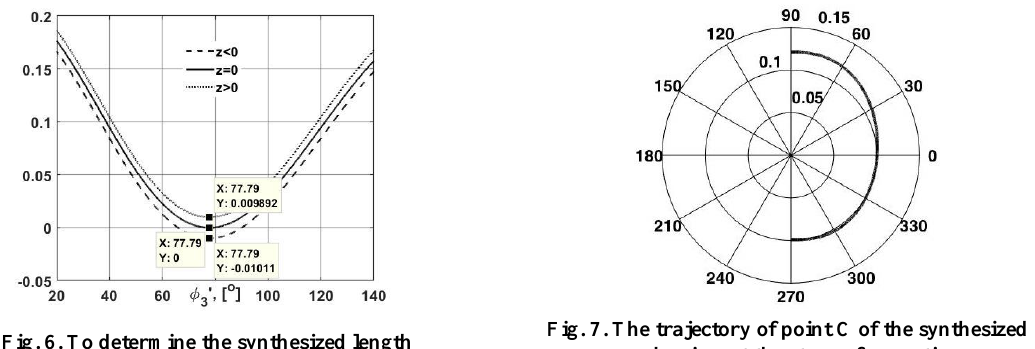
Fig. 6. To determine the synthesized length of the shuttle CD